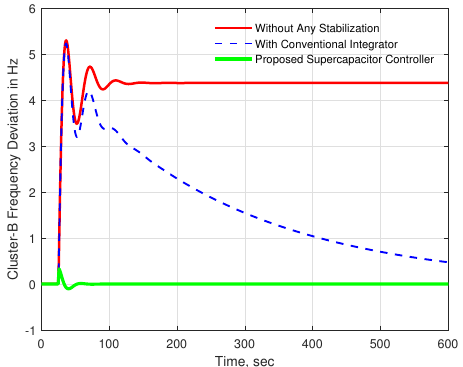
Figure 15. Frequency response for cluster B 0.15 p.u. disturbance in cluster B. A comparison of disturbances applied in Cluster B is depicted in Figure 16 for all scenarios.